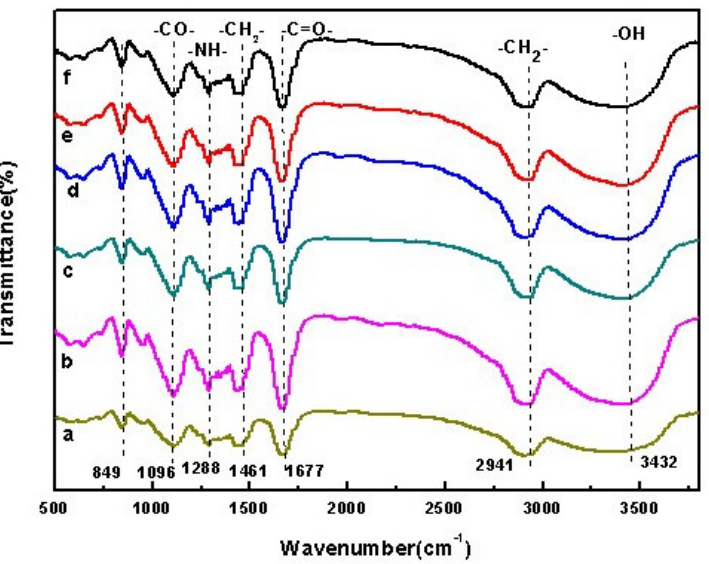
Figure 1. FTIR absorption spectrum of OF/PVP/PVA hydrogels with different concentrations of os- manthus extract. ( a ): 400 μg/mL; ( b ): 200 μg/mL; ( c ): 100 μg/mL; ( d ): 50 μg/mL; ( e ): 25 μg/mL; ( f ): 0 μg/mL.